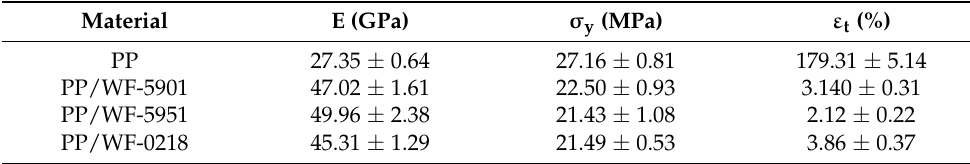
Table 1. Mechanical parameters of neat PP and PP/WF